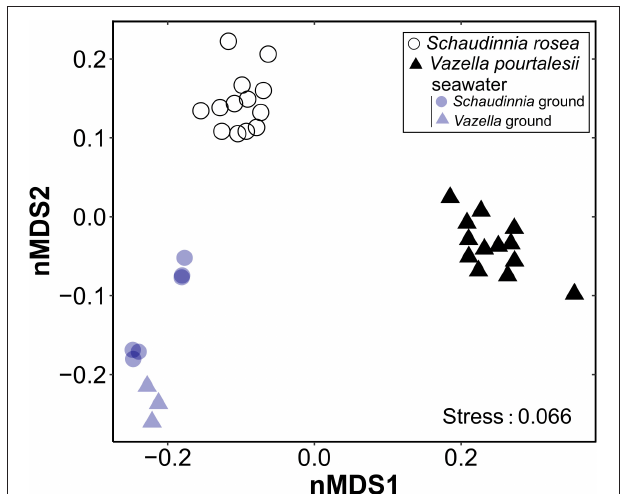
FIGURE 5 | Non-metric dimensional scaling (nMDS; k = 2, maxit = 100) plot on weighted UniFrac distances for each of the assayed sponge species, Vazella pourtalesii and Schaudinnia rosea , and the seawater of their respective habitats. The results of the PERMANOVA tests that gives statistical support to the between-group differences is given in Supplementary Table 3